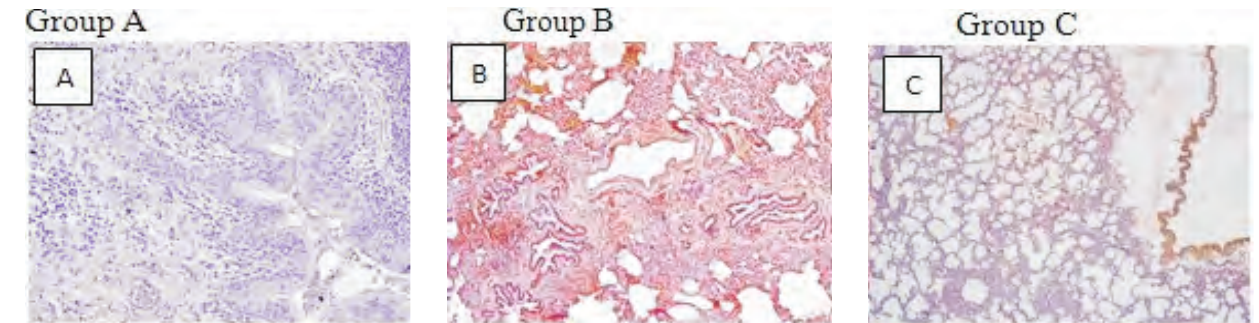
Figure-1. A: M. haemolytica antigens demonstrated by the red chromogen in the cytoplasm of alveolar macrophages, exudates in the bronchioles and in blood vessels B: in the cytoplasm of interstitial, alveolar macrophages, bronchial epithelium and in alveolar spaces and C: in the cytoplasm of alveolar, interstitial macrophages and pleura Avidin-biotin-peroxidase method